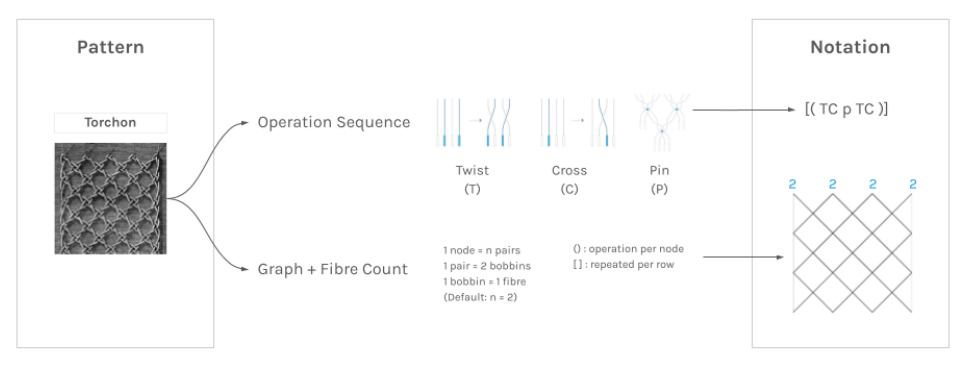
Figure 3. Translating lace patterns to notations for action sequences and graphical fibre